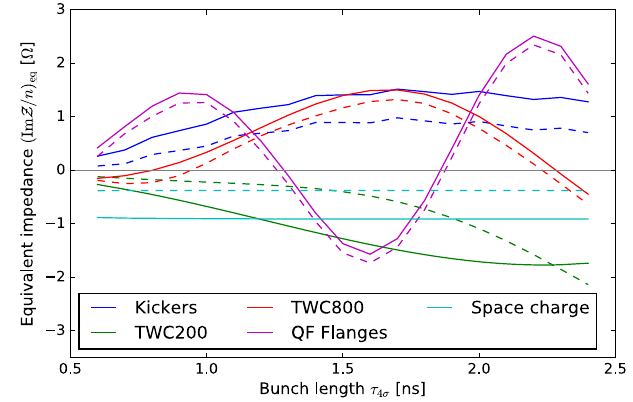
FIG. 11. The equivalent impedance ð Im Z =n Þ of the main SPS eq impedance sources in Fig. 1 taken separately. The solid lines correspond to the equivalent impedances defined only from the incoherent shift Δ f as in Fig. 9, the dashed lines correspond to inc the equivalent impedances taking also into account the coherent shift Δ f coh ; 2